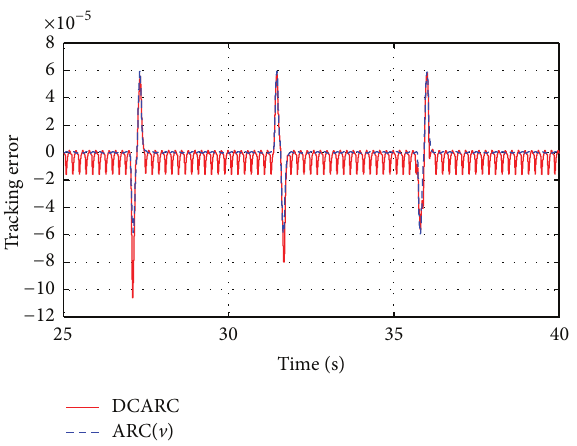
Figure 12: Scaled ARCs’ tracking errors in point to point motion in